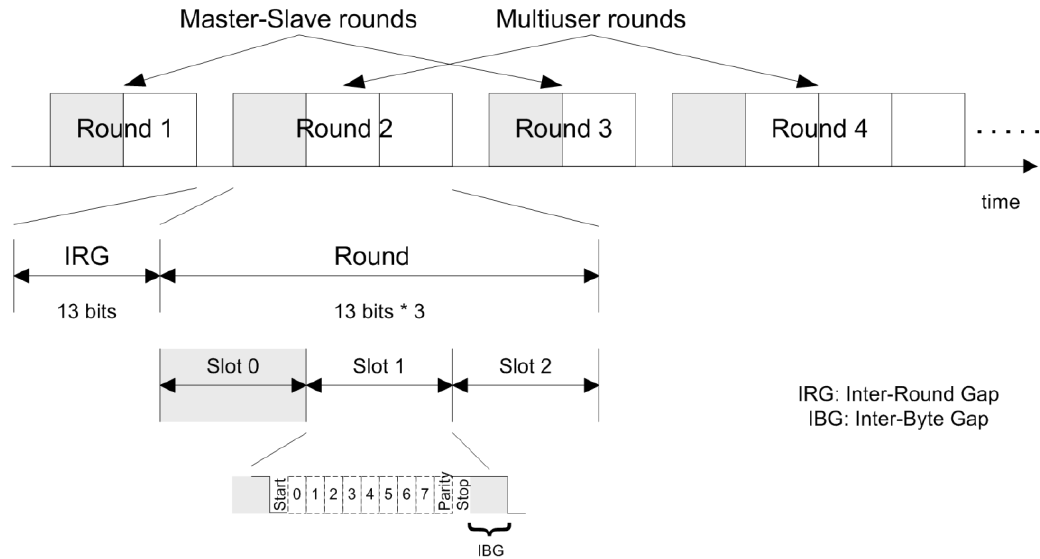
Figure 4. Format communication protocol